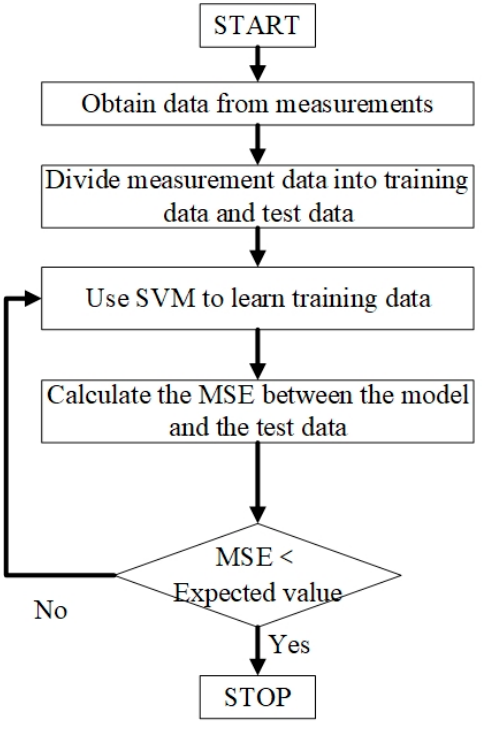
Figure 3. Modeling flow chart of PA temperature characteristics based on SVM.